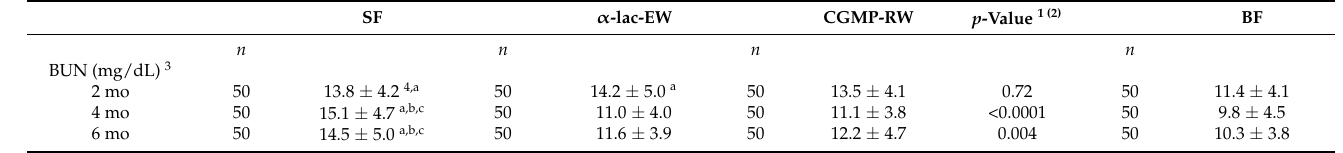
Table 7. Mean concentration (unadjusted) of blood urea nitrogen (BUN), s-IGF-1, insulin, c-peptide, leptin, leptin receptor, free leptin receptor index (FLI), hemoglobin (Hb), ferritin and iron in infants fed formula (SF, α -lac-EW or CGMP-RW) * or breast milk (BF) during the intervention, ITT population, and for BUN in the randomized